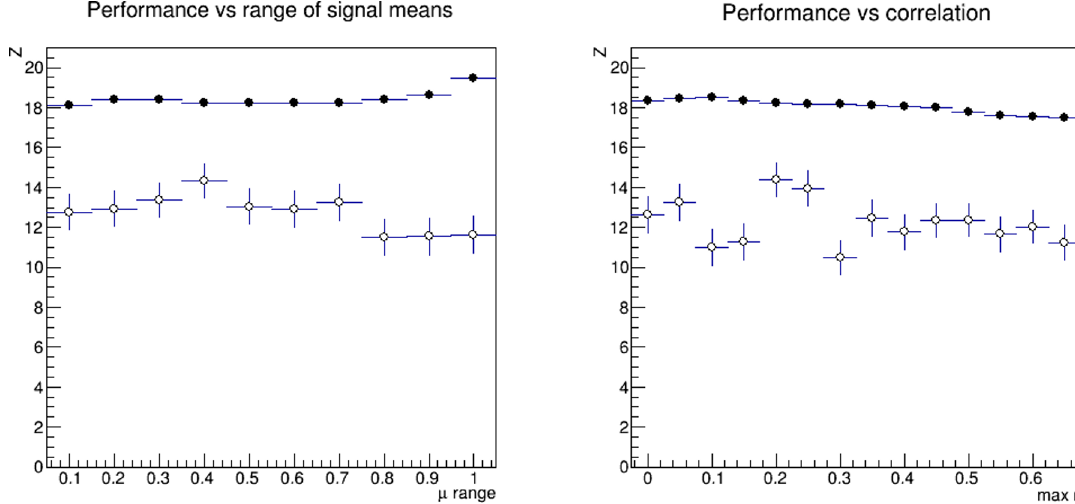
Figure 5 . Mean values of the Z PL test statistic as a function of the characteristics ( ∆ µ g for r gh = 0 . 2 (left), and r gh for ∆ µ g = 0 . 7 (right)) of the signal component, obtained from 50 repetitions of searches in synthetic datasets, each composed of 50 signal events and 4950 background events as discussed in the text. Black points correspond to searches initialized with Algorithm 2, while empty points correspond to searches initialized with Algorithm 0. For reference, the critical region (for α = 0 . 05 ) corresponds to Z = 7 . 1(7 . 2) for Algorithm 0 (2, respectively). See the text for PL more